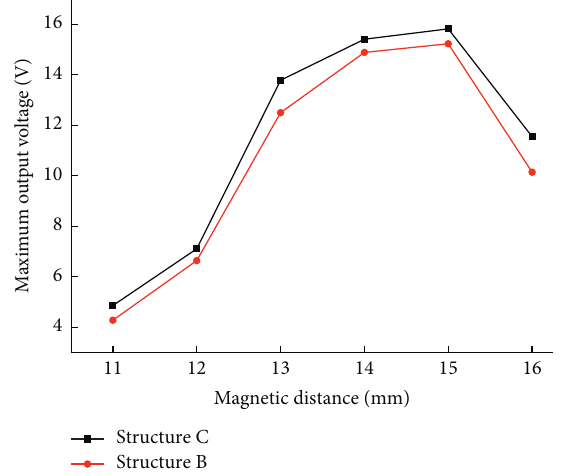
Figure 11: Maximum output voltage of the structure B and the structure C.